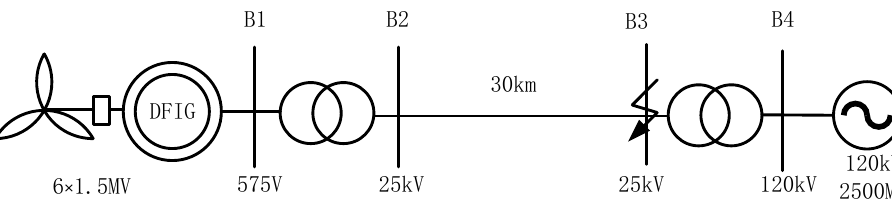
Figure 7. DFIG parallel to infinity system model. Set the model parameters as shown in Table 3.